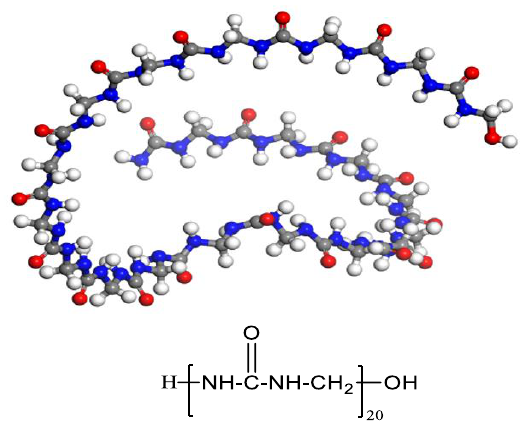
(b) PUF Figure 1. The model of the poly (urea-formaldehyde) (PUF) molecular Figure 1. The model of the poly (urea-formaldehyde) (PUF) molecular chain.